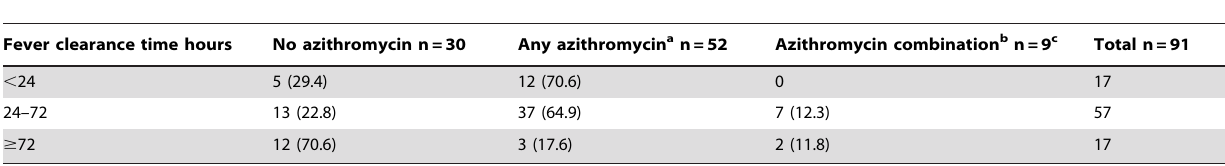
Fever clearance time